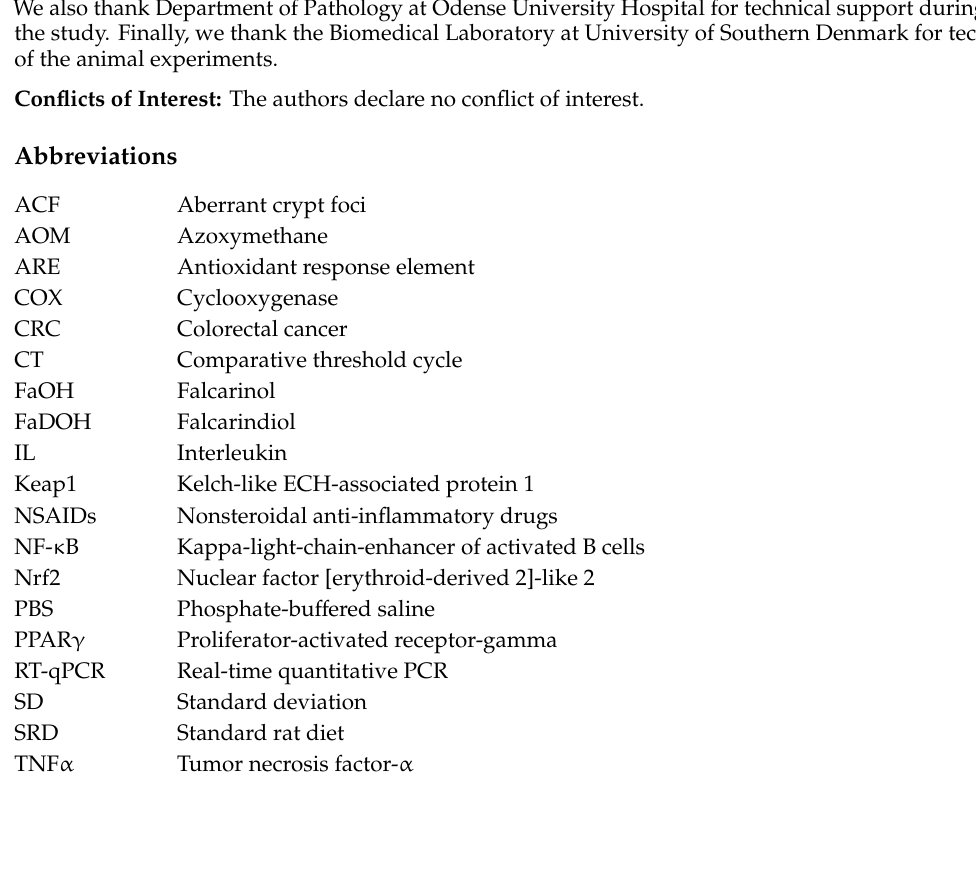
Table S1: Primer sequences used for analysis of gene expression, Figure S1: The macroscopic polyp lesions in the AOM-treated rats varied in size from (A) large adenomas to (B) small adenomas. The adenomas were generally smaller in rats on a SRD supplemented with FaOH and FaDOH compared to rats on a SRD (control group). In addition, the percentage of large adenomas of the total macroscopic polyp lesions was highest in the control